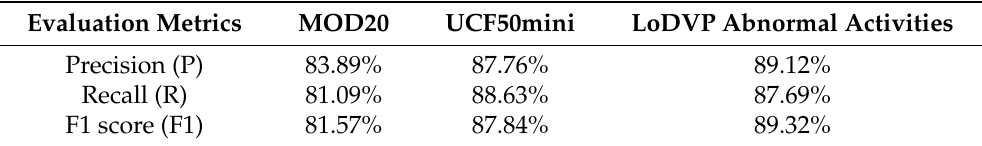
Table 6. The evaluation criterion of the proposed neural network architectures using different datasets.